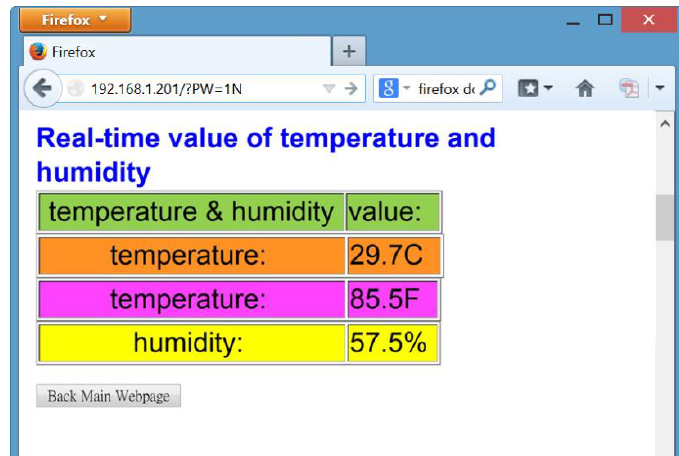
Figure 12. Using the browser to view real-time temperature and humidity data in the integrated